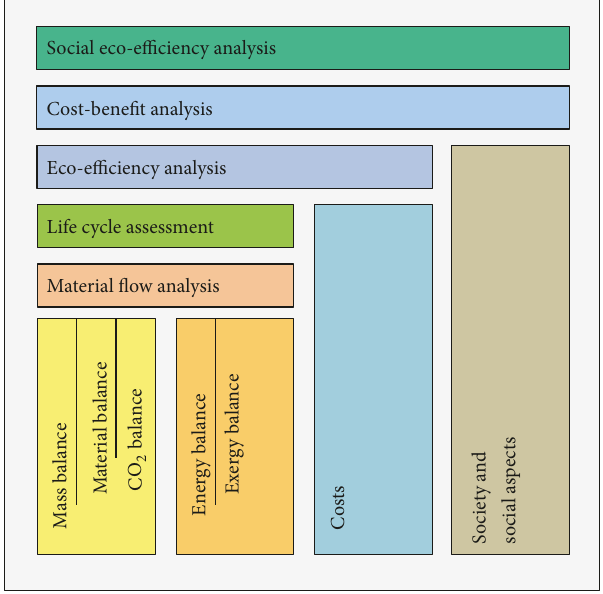
Figure 3: Overview of the methods used for the evaluation of processes.